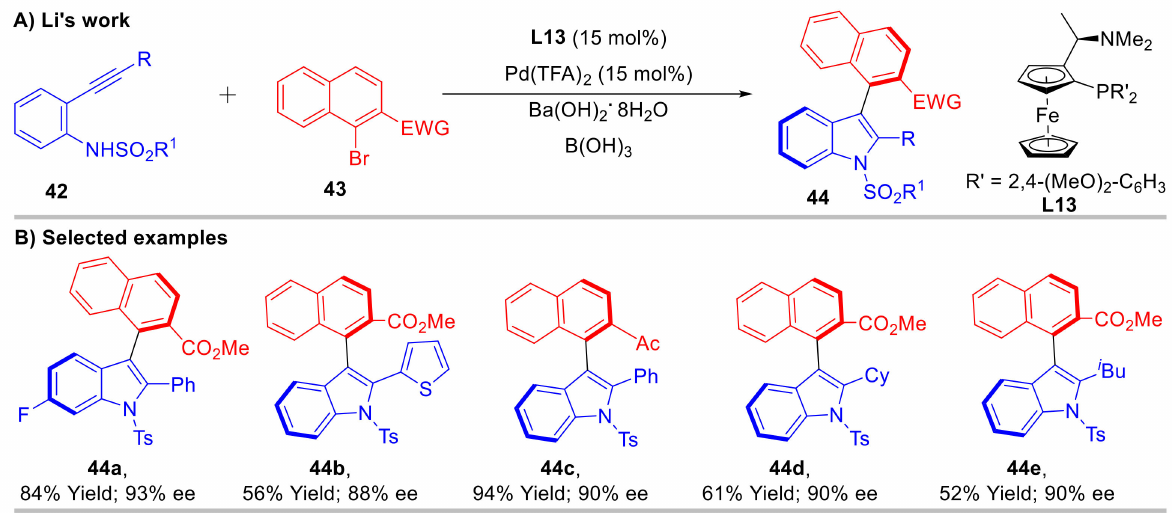
Scheme 13. Construction of atropisomeric